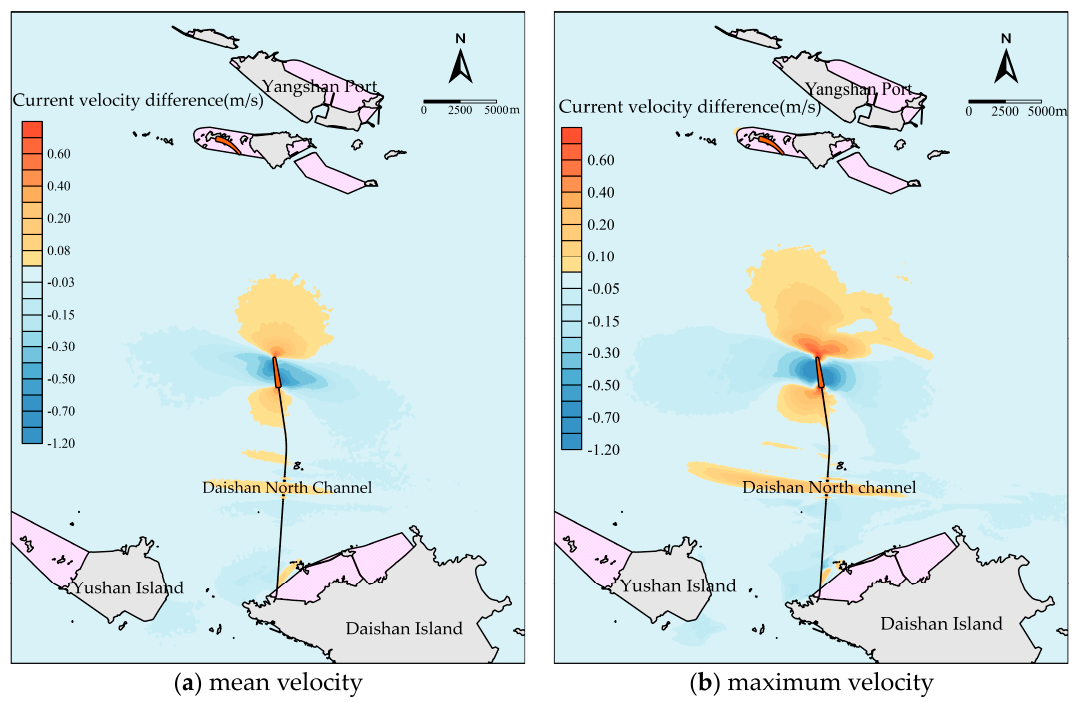
Figure 11. The simulated current velocity difference (The positive value represents the increase in current velocity, and the negative value represents the decrease in current velocity).